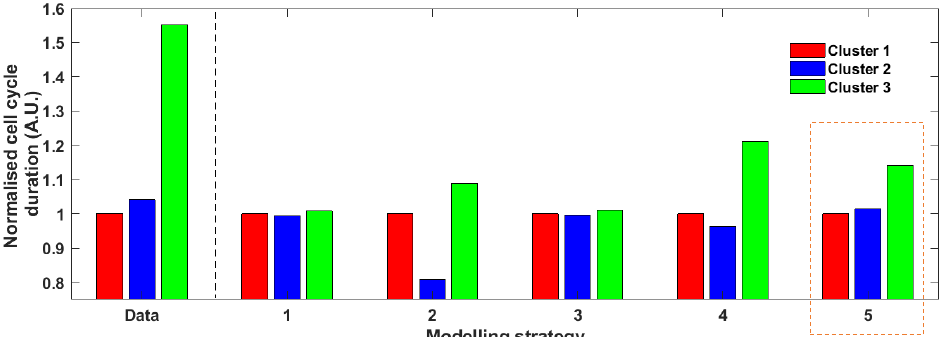
Figure 6. Results of the solutions to model (5) with no parameter constraints when θ ( i ) timised to the data vector Θ , i = 1,2,3, frequency parameters are set as ω Hes1 = 24 − 1 and Hes1 ω C.C. = 27 − 1 . ( A – C ) Square torus diagram trajectories of solutions θ over data trajectories from Figure 2B. ( D – F ) Pseudo-time plots of rebuilt Hes1 dynamics found via (cid:16) (cid:17) ( i ) θ cos , i = 1, 2, 3 superimposed over mean traces from Figure 2A. In ( A – F ), the black lines denote Hes1 the model results, coloured lines denote the data (red: cluster 1, blue: cluster 2 and green: cluster 3), and in ( D – F ), the shaded areas denote the standard deviations of the data. ( G ) Bar chart of cell cycle duration predictions from the simulation for each cluster case.